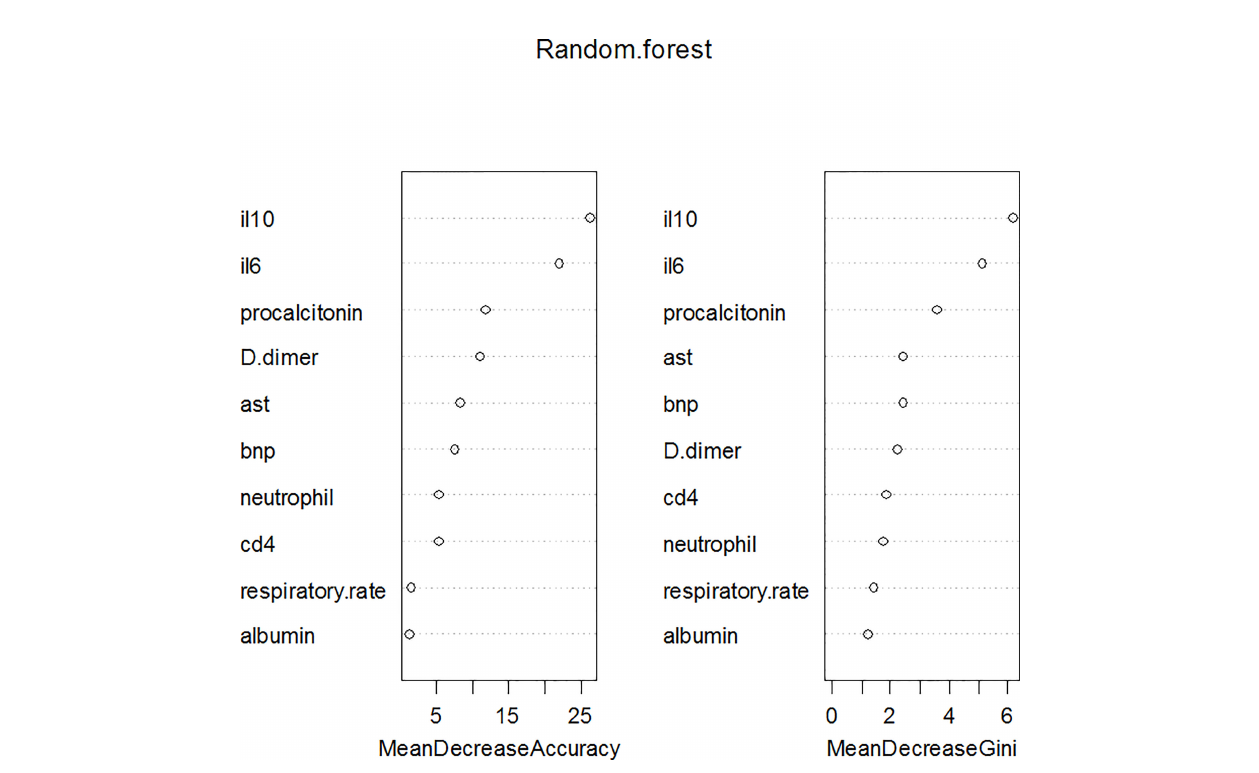
FIGURE 3 | Variable importance plot using RF model for the critically ill COVID-19 pneumonia patients. IL-10 and IL-6 were the most important variables in determining critical illness by either mean decrease accuracy or by mean decrease Gini.